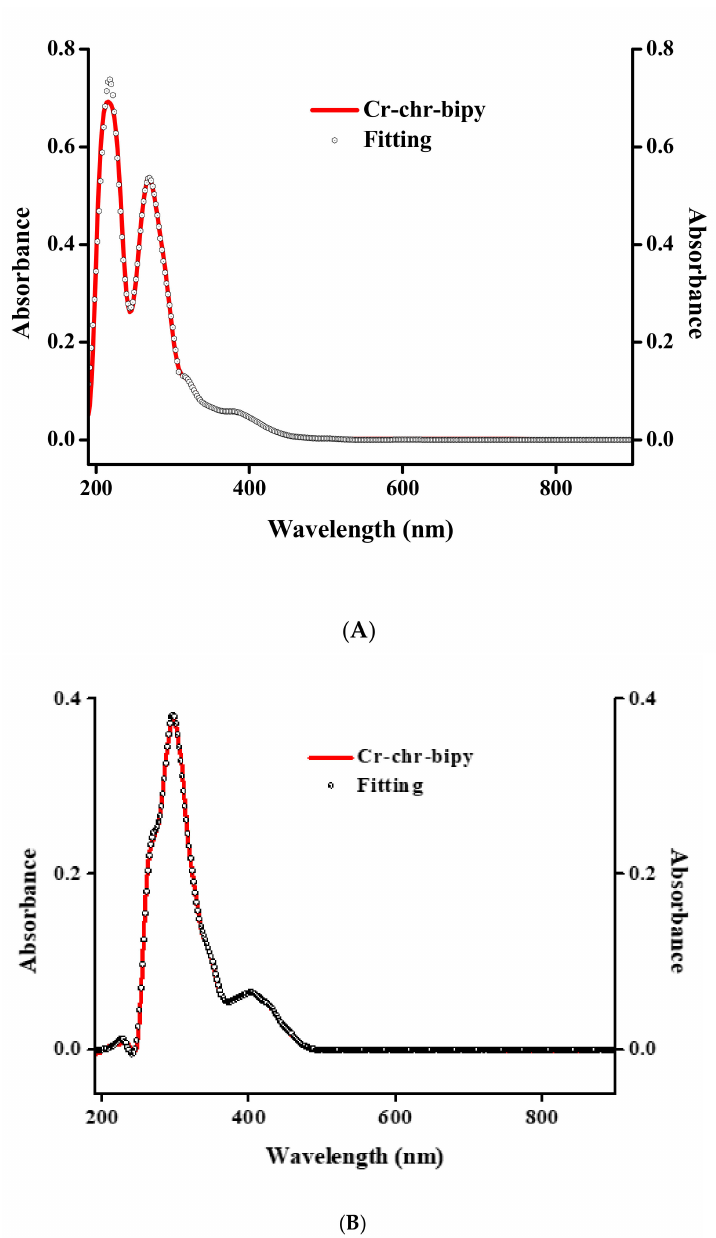
Figure 3. ( A ) UV-Visible spectrum (red line) and spectral fitting (circles) of compound 1 in methanol (10 − 5 M). ( B ) UV-Visible spectrum (red line) and spectral fitting (circles) of compound 1 in DMSO (10 − 5